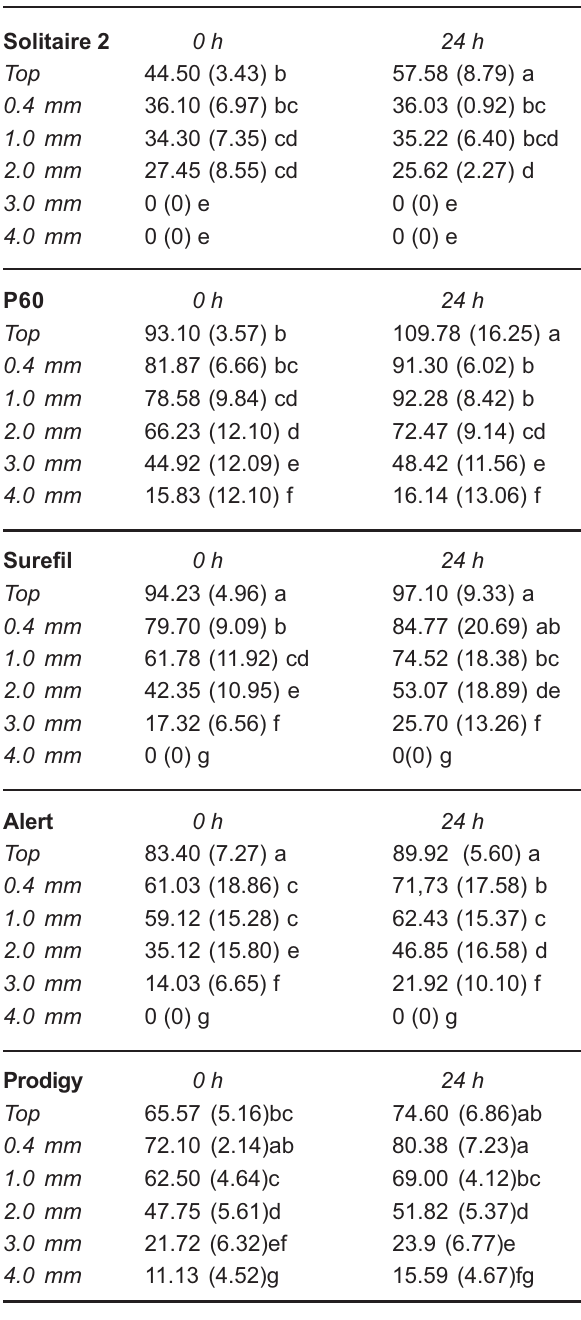
TABLE 2- Microhardness means and standard deviations of the